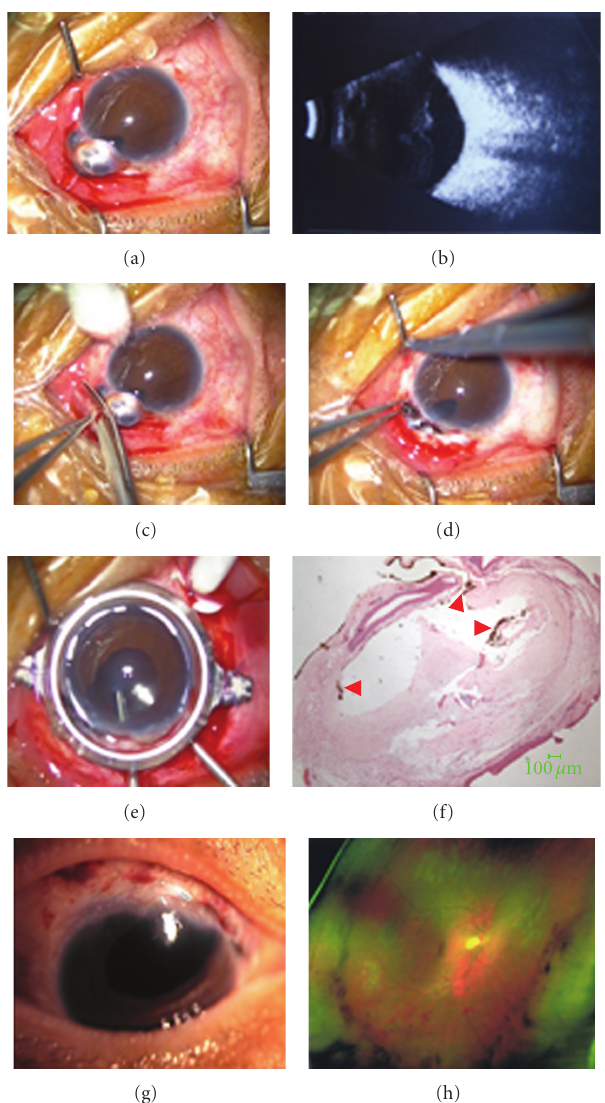
Figure 1: Clinical photograph, ultrasonographic fundus photo- graph and histopathology of right eye. (a) A brown protruding bulge occupied the entire nasal quadrant with a clear boundary seen at the outer edge of the corneoscleral limbus. The cornea was transparent, the anterior chamber was shallow and about 1/3CK, the pupil shifted up and dwindled with an apparent discoria. (b) B- scan showed vitreous opacity with posterior vitreous detachment. (c) The bulbar conjunctiva around the anterior staphyloma on the superior nasal quadrant was separated; the prolapsed uveal tissues and vitreous body were pruned during operation. (d) After surgical removal of the anterior staphyloma, the apparent thinning and perforated sclera at 12:00–2:30 position and iridoleptynsis on the superior nasal quadrant was observed. (e) The shifted-up iris was cut to recover a circular pupil and to clear vitreous hemorrhage by vitrectomy. (f) The removed specimens were confirmed as anterior staphyloma with the existence of pigment cells (arrowhead) by pathological examination. (g,h) Re-examination three months after operation: the right cornea was transparent, the stitches of corneoscleral junction on the superior nasal quadrant were eutopic, the anterior chamber was deep and the pupil was circular; the retina was procumbent by